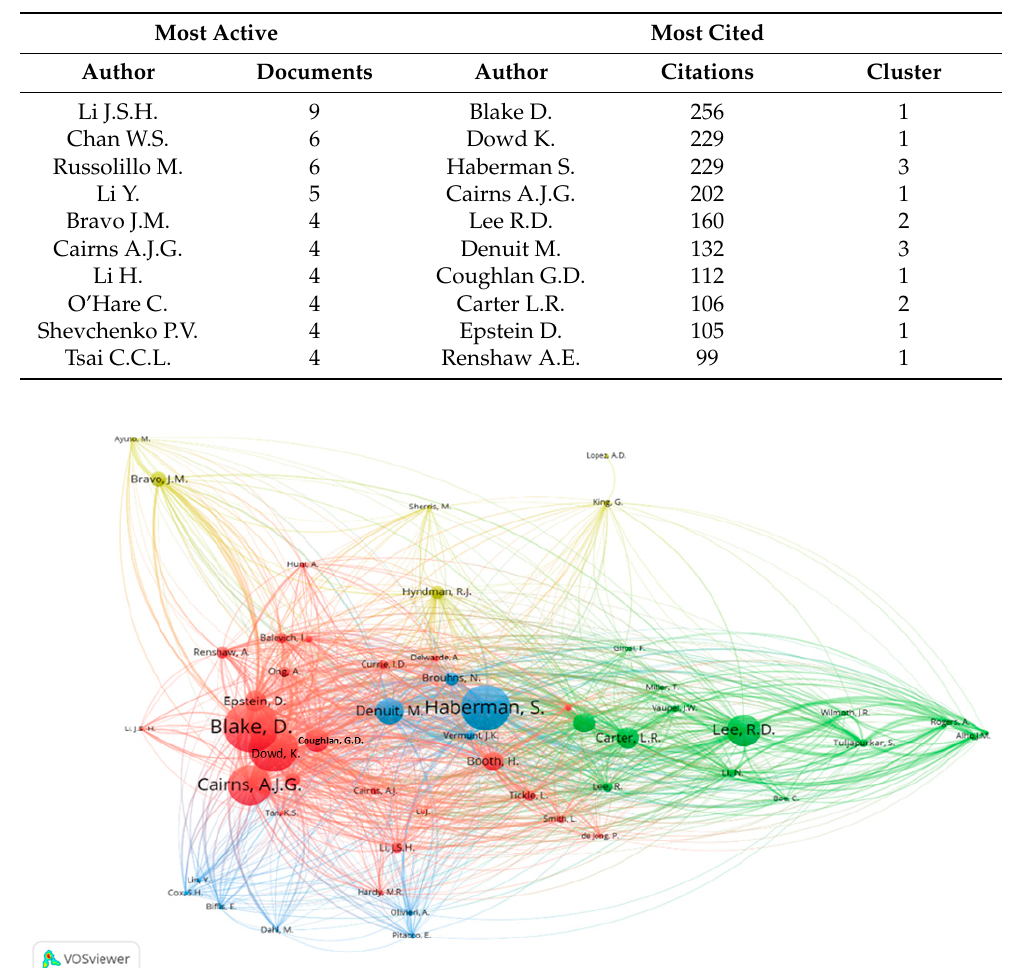
Figure 3. Authors’ co-citation network for mortality forecasting and modelling. Red represents cluster 1, green represents cluster 2, blue represents cluster 3 and yellow represents cluster 4.